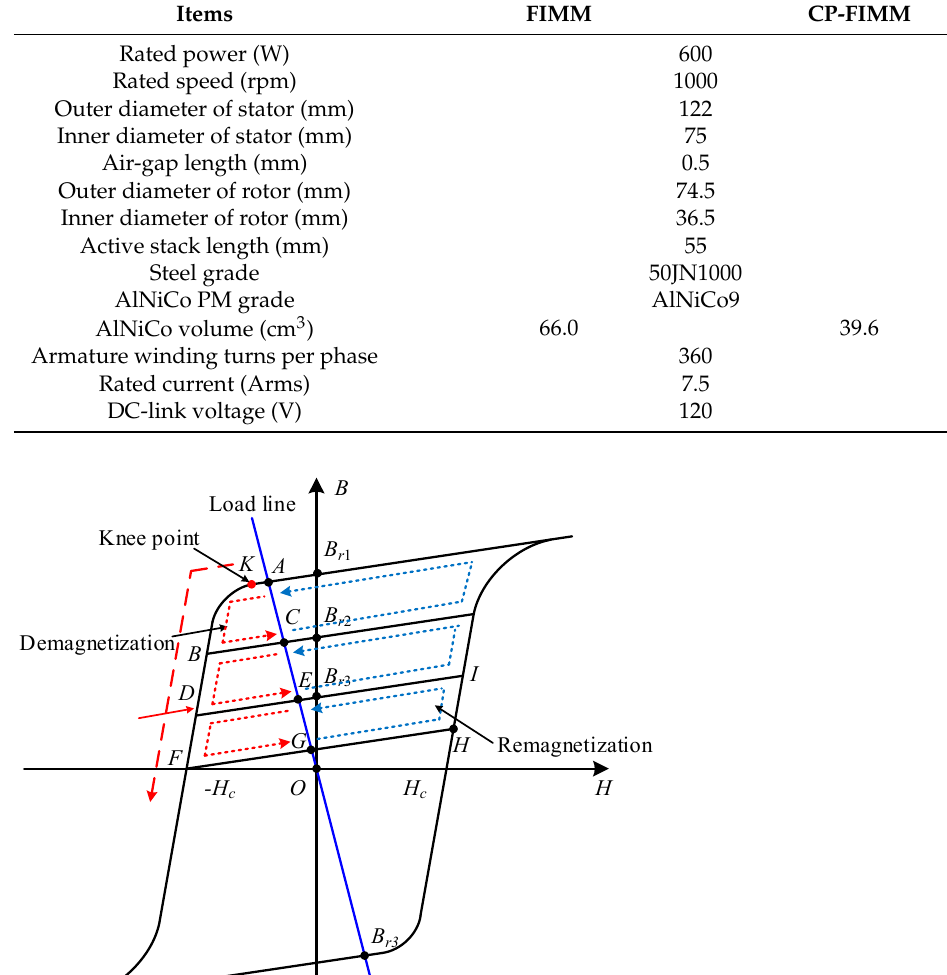
Figure 1. Machine topology. ( a ) FIMM, ( b ) CP-FIMM. Table 1. Key design parameters of FIMM and CP-FIMM.